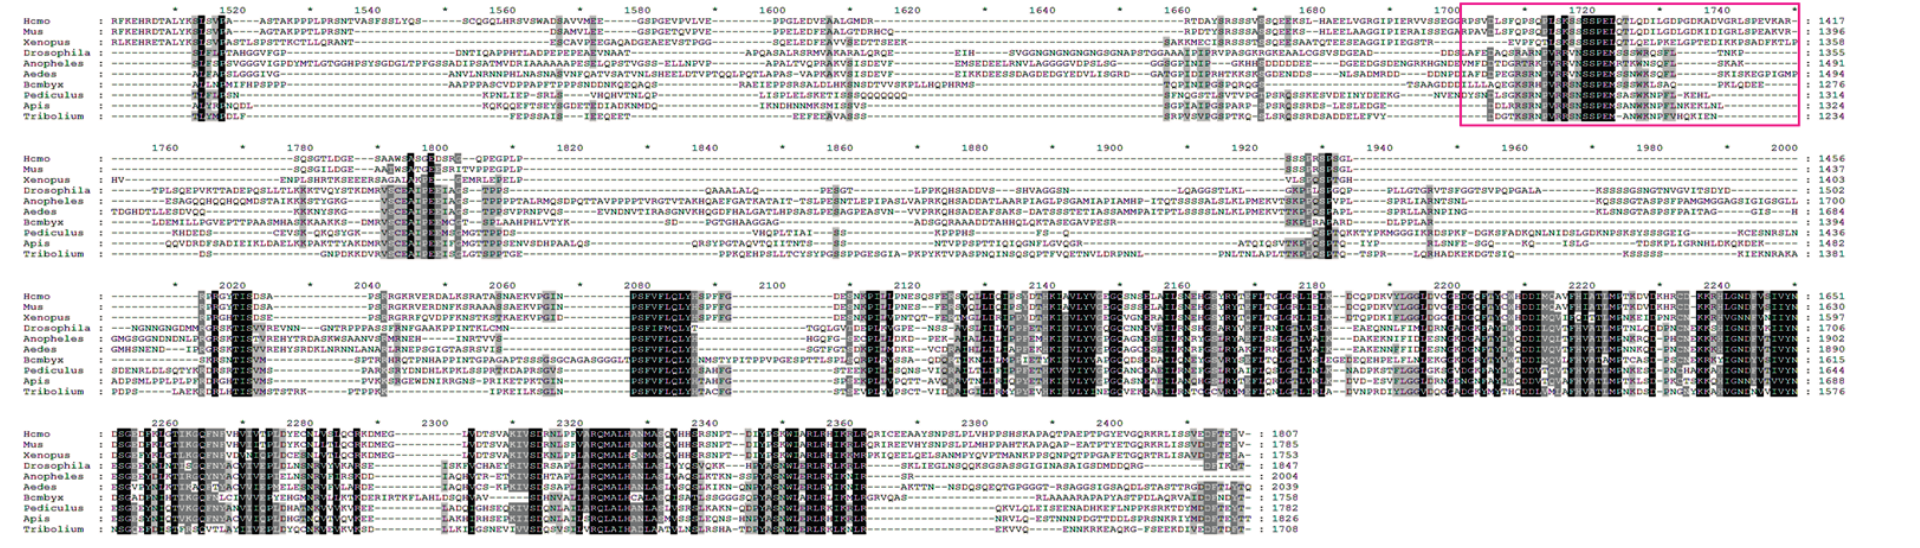
Figure 2. Multiple sequence alignment of tuberous sclerosis complex 2 (TSC2)-like proteins from different vertebrate and invertebrate species. Sequence alignment was conducted using CLUSTALW using TSC2 from the following animal species (from top to bottom): Homo sapiens , Mus musculus , Xenopus tropicalis , Drosophila melanogaster , Anopheles gambiae , Aedes aegypti , Bombyx mori , Pediculus humanus corporis , Apis mellifera , Tribolium castaneum . Pairwise alignment parameters are: Gap Open Penalty: 10.0, Gap Extension Penalty: 0.1, Weight Matrix: BLOSUM. Multiple alignment parameters are: Gap Open Penalty: 10.0, Gap Extension Penalty: 0.05, Weight Transition: YES (Value: 0.5), Hydrophilic Gaps: YES, Weight Matrix: ID (identity matrix). The alignment was constructed at GenomeNet (Kyoto University Bioinformatics Center) and rendered in GeneDoc v.2.7. Numbers and stars (*) above the sequences mark every 10 amino acids (a.a.). Residues were shaded according to their conservation between the examined species (black, 100%; dark grey, 80–99%; light grey, 60–79%). Red box highlights the conserved AMPK phosphorylation site, which is analyzed in more detail in Figure